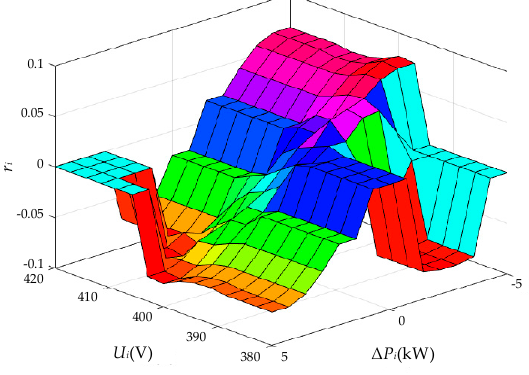
Figure 7. Fuzzy logic reasoning results.